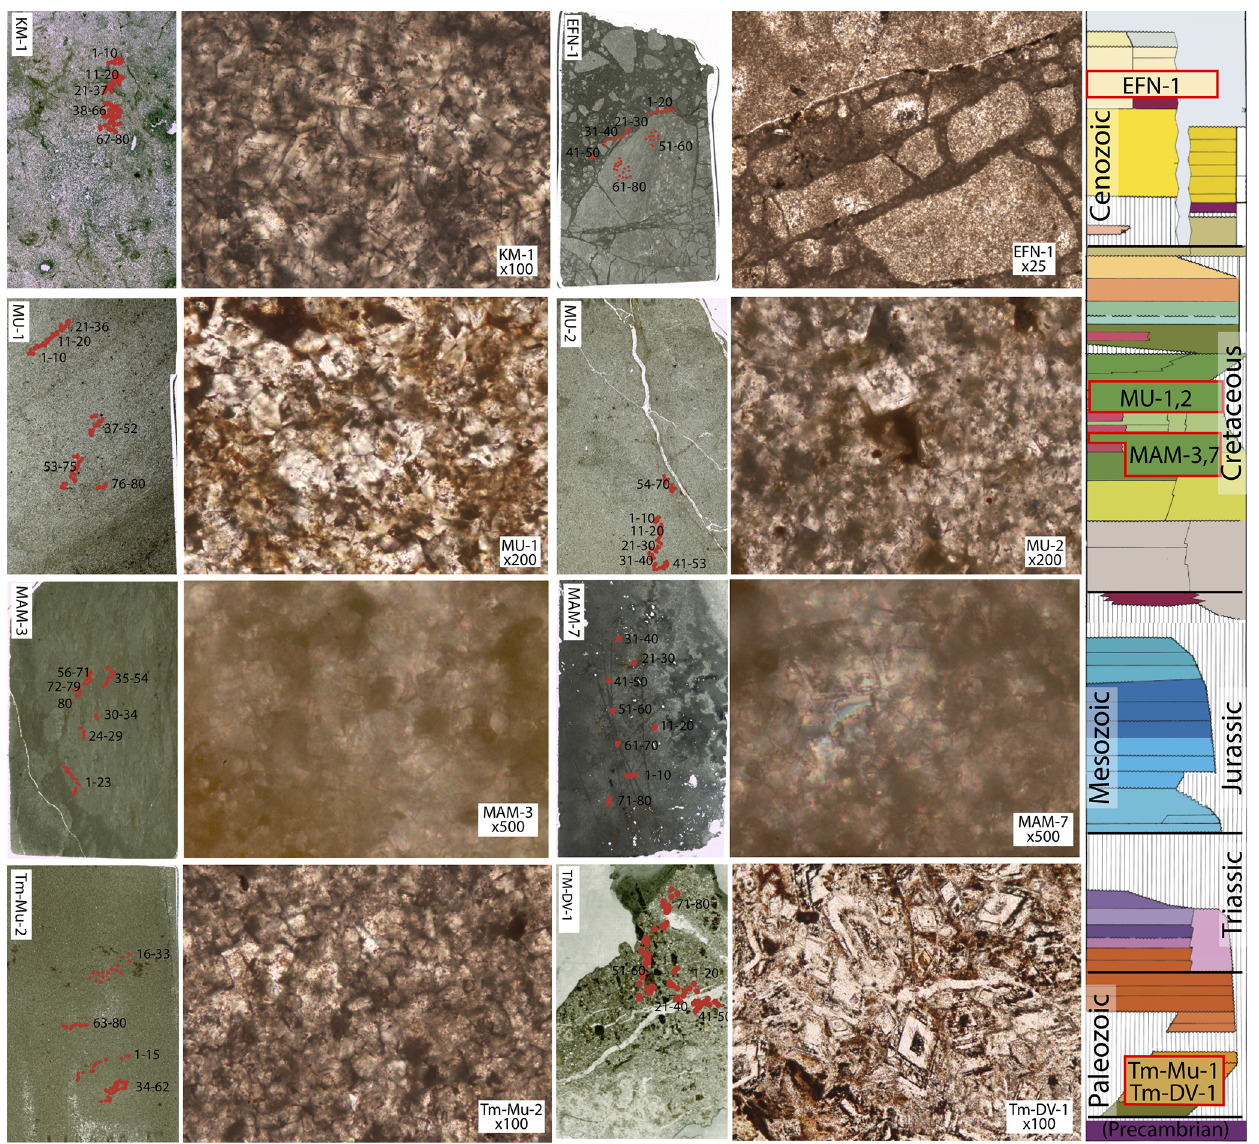
Figure 1. Thin-section scans and representative photomicrographs of each dolomitic sample from this study. Red dots on thin-section scans show the locations of LA-ICP-MS analyses. The width of thin sections is 27mm. Sample locations along the stratigraphic column of Israel are also provided in the right